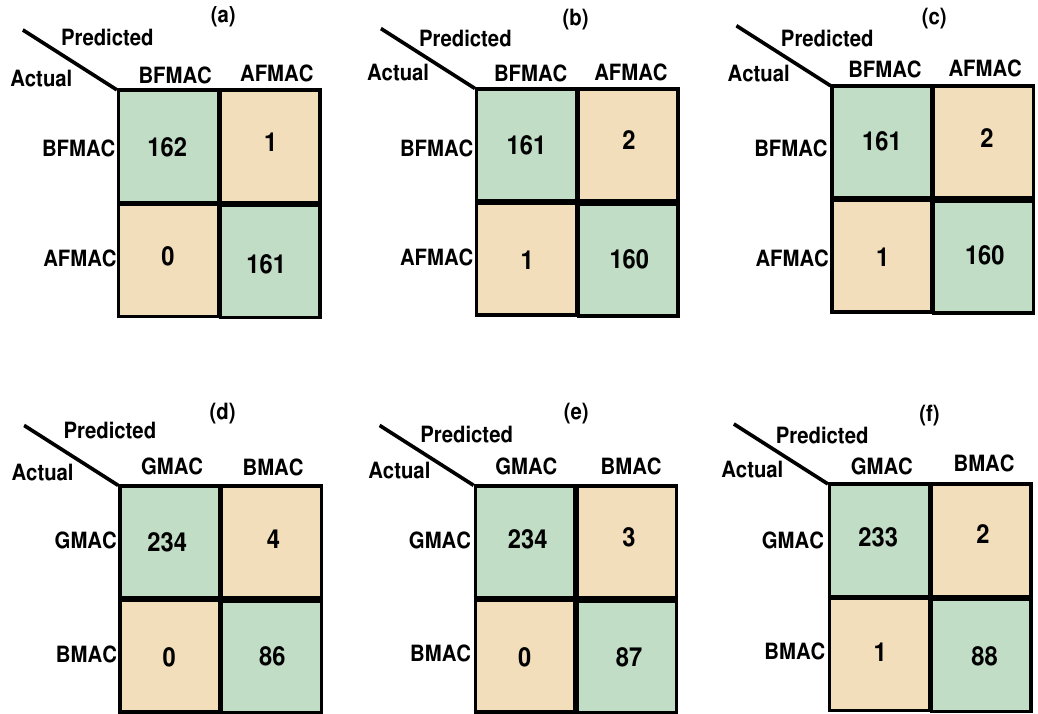
Figure 13. ( a ) Confusion matrix of the LSTM classifier for the BFMAC vs. DMAC classification task using one trial hold-out CV, ( b ) Confusion matrix of the BLSTM classifier for the BFMAC vs. DMAC classification task using one trial hold-out CV, ( c ) Confusion matrix of the GRU classifier for the BFMAC vs. DMAC classification task using one trial hold-out CV, ( d ) Confusion matrix of the LSTM classifier for the GMAC vs. BMAC classification task using one trial hold-out CV, ( e ) Confusion matrix of the BLSTM classifier for the GMAC vs. BMAC classification task using one trial hold-out CV, ( f ) Confusion matrix of the GRU classifier for the GMAC vs. BMAC classification task using one trial hold-out